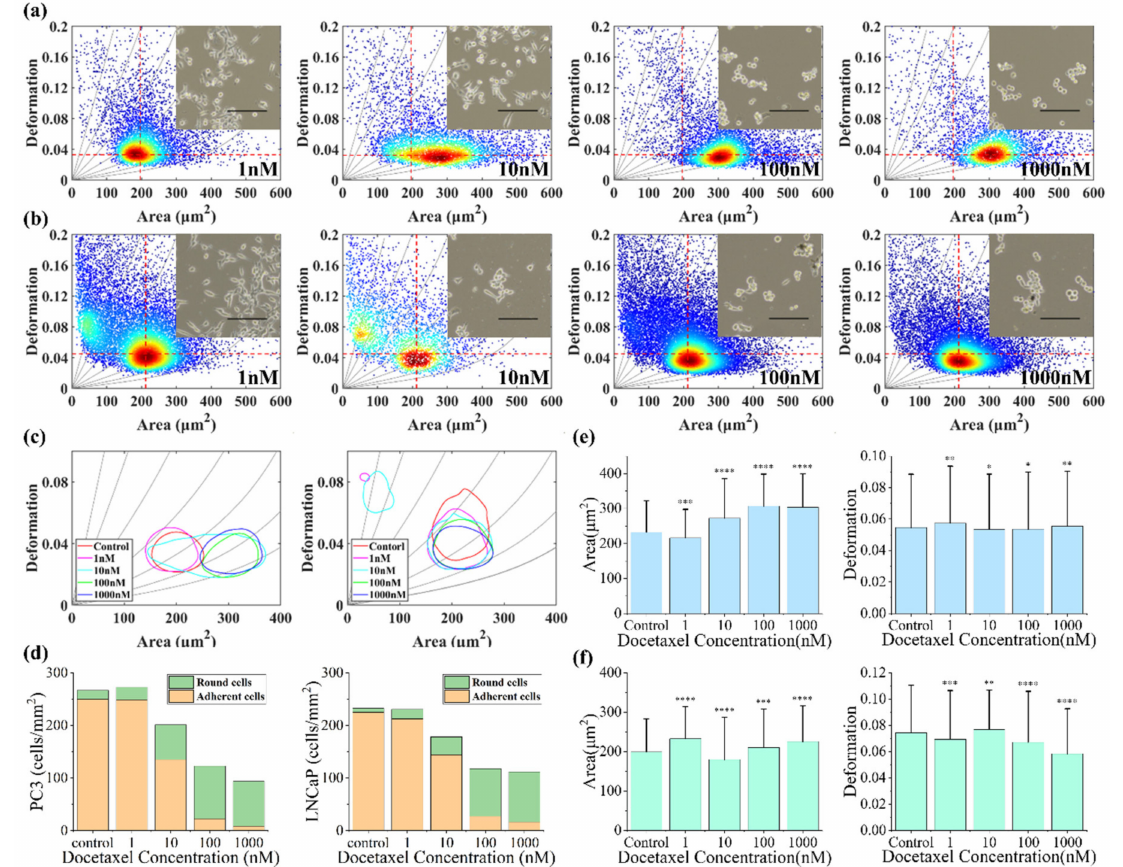
Figure 5. ( a ) The deformation versus area scatter plots of PC-3 cells cultured in cell medium containing different docetaxel concentrations after 24 h. ( b ) The deformation versus area scatter plots of LNCaP cells cultured in cell medium containing different docetaxel concentrations after 24 h. The order is 1 nmol/L, 10 nmol/L, 100 nmol/L and 1 µ mol/L. ( c ) The 50% density contour line of different docetaxel concentrations on PC-3 and LNCaP cells. ( d ) Quantity trends of round cells and adherent cells in PC-3 and LNCaP cells. ( e ) The average degree of PC-3 cell area and deformation under docetaxel. ( f ) The average degree of LNCaP cell area and deformation under different docetaxel concentrations. *, **, *** and **** indicate p values of less than 0.05, 0.01, 0.001 and 0.0001, respectively. The red dotted lines for references represent the median of the control group PC-3 and LNCaP cells’ cross-sectional area and deformation. The inset shows the optical microscopic images of untreated control group and docetaxel-treated cells. The scale bar represents 200 µ